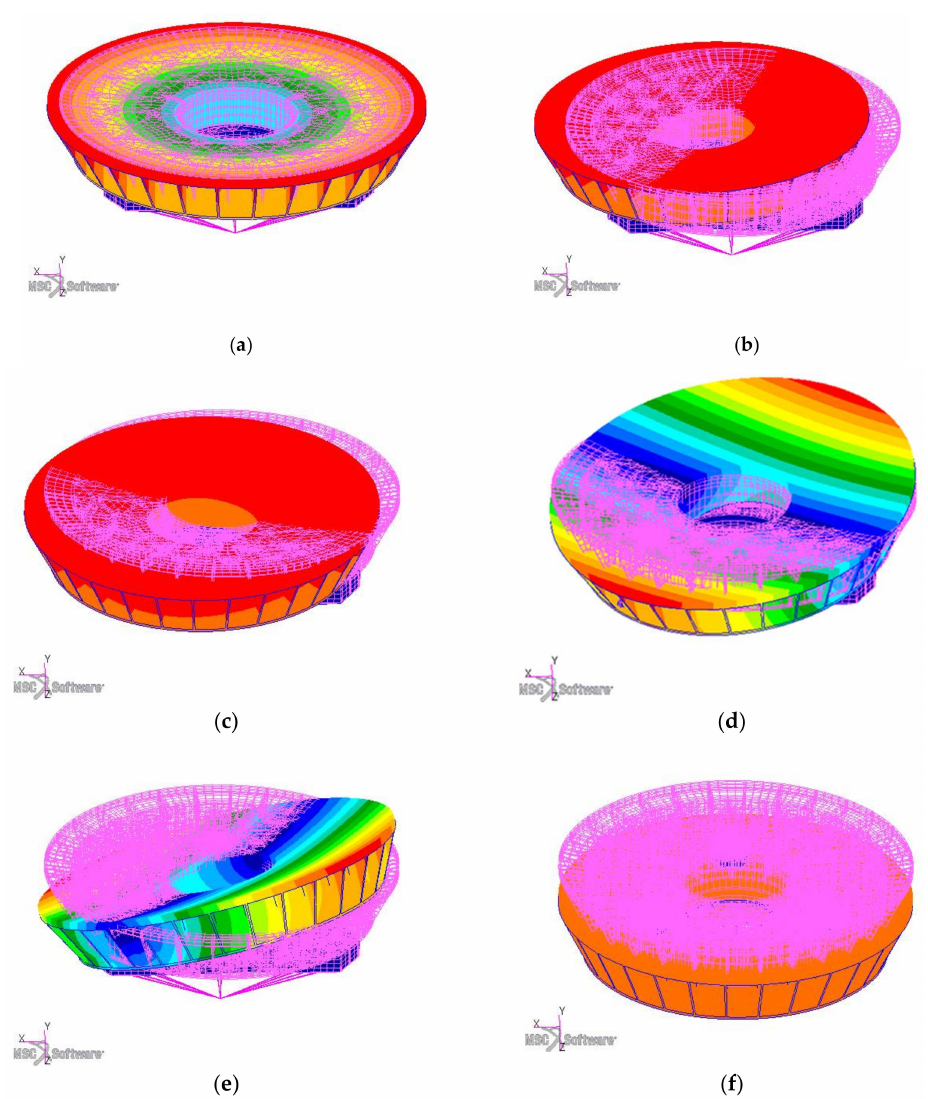
Figure 5. Modal shapes of the first 6 modes: ( a ) F1 = 204.35 Hz, rotated about z; ( b ) F2 = 228.95 Hz, trans along x; ( c ) F3 = 228.95 Hz, trans along y; ( d ) F4 = 274.52 Hz, rotated about x; ( e ) F5 = 274.52 Hz, rotated about y; and ( f ) F6 = 318.42 Hz, trans along